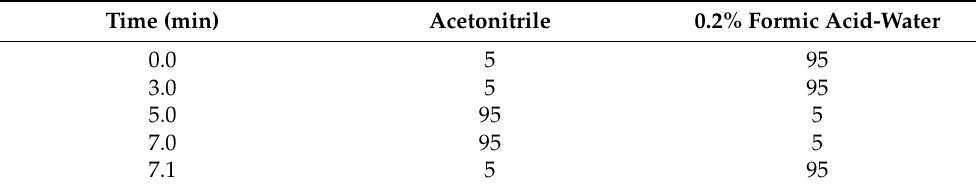
Table 11. Linear gradient elution procedure of nifedipine and